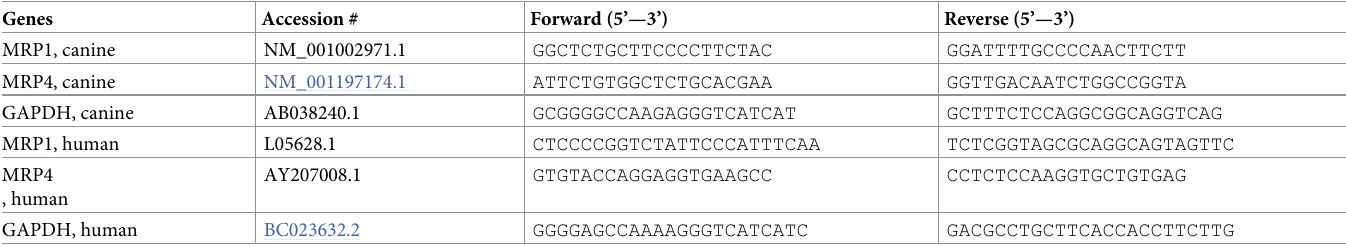
Table 1. Primer sequences for